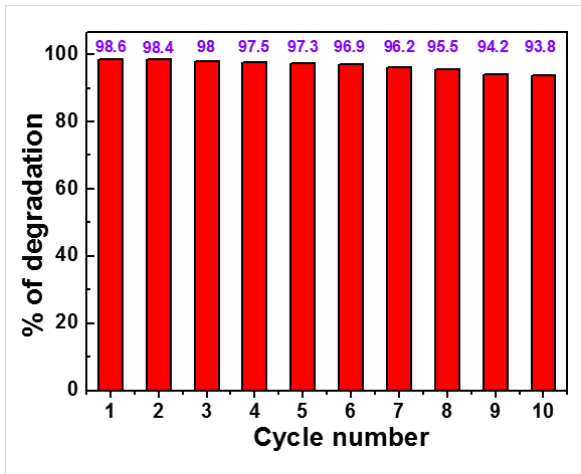
Figure 10: Recycling of the CdSe (2 wt %)/TiO 2 catalyst in the degra- dation of RhB under simulated solar light irradiation.